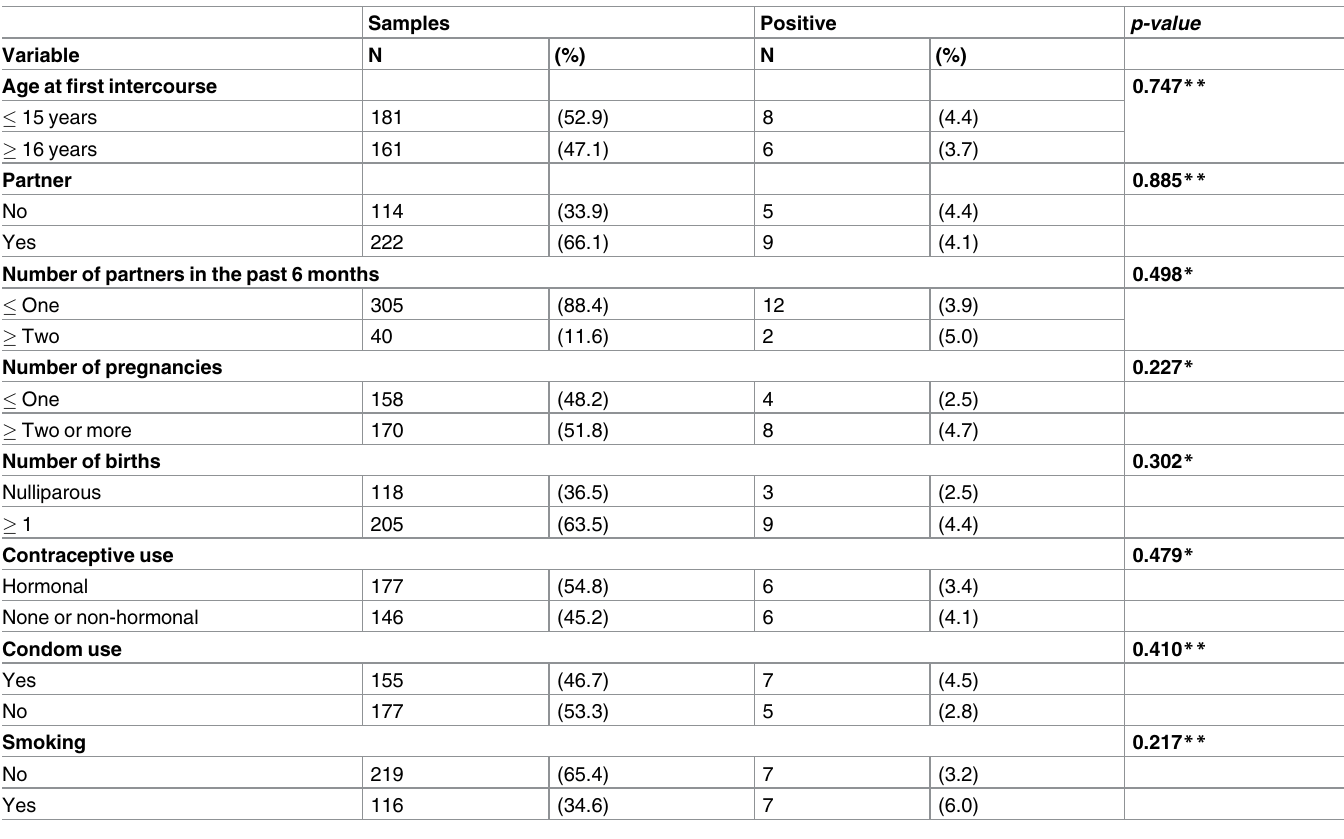
Table 3. Bivariateanalysisof the data associatedwith the behaviour and clinical history of women treatedat the University Hospital of Rio Grande, Rio Grande do Sul, Brazil. Trichomoniasis was diagnosed using Polymerase ChainReaction(PCR) with the TVK3/7 primer set. Period between January 2012 and January2015 (n =